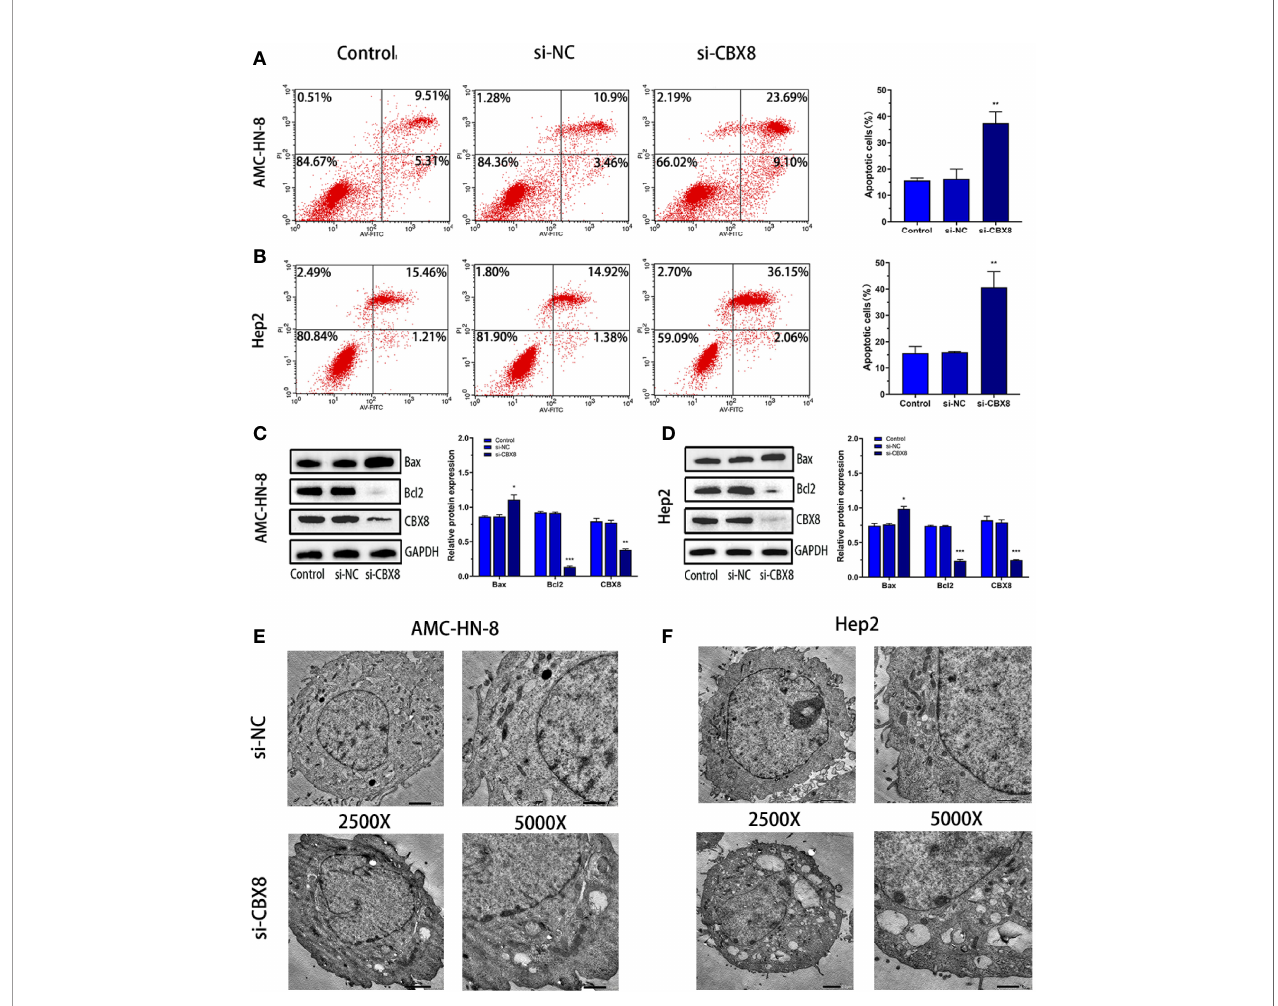
FIGURE 4 | Knockdown of CBX8 can promote apoptosis and autophagy in LSCC cells. (A , B) After knockdown of CBX8, cell apoptosis in each group was detected by fl ow cytometry. (C, D) Western blotting was used to detect the protein expression of CBX8, Bax and Bcl2 in AMC-HN-8 and Hep2 cells. (E , F) Morphological changes in CBX8 cells were observed by transmission electron microscopy.Each assay was repeated at least three times. Data from one representative experiment is presented as Mean ± SEM (*P < 0.05, **P < 0.01, ***P <